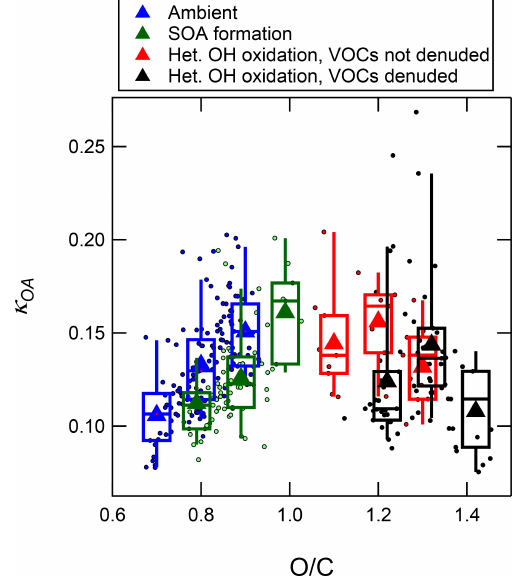
Figure 11. Binned averages of hygroscopicity of OA ( κ OA ) mea- sured at 160nm as a function of bulk O : C of the OA. The data include ambient data, measurements after 1–3 eq. days OH aging to sample maximum SOA formation, and measurements after 12–44 eq. days aging sampled through (or not through) a gas denuder in order to sample the result of heterogeneous oxidation of preexisting